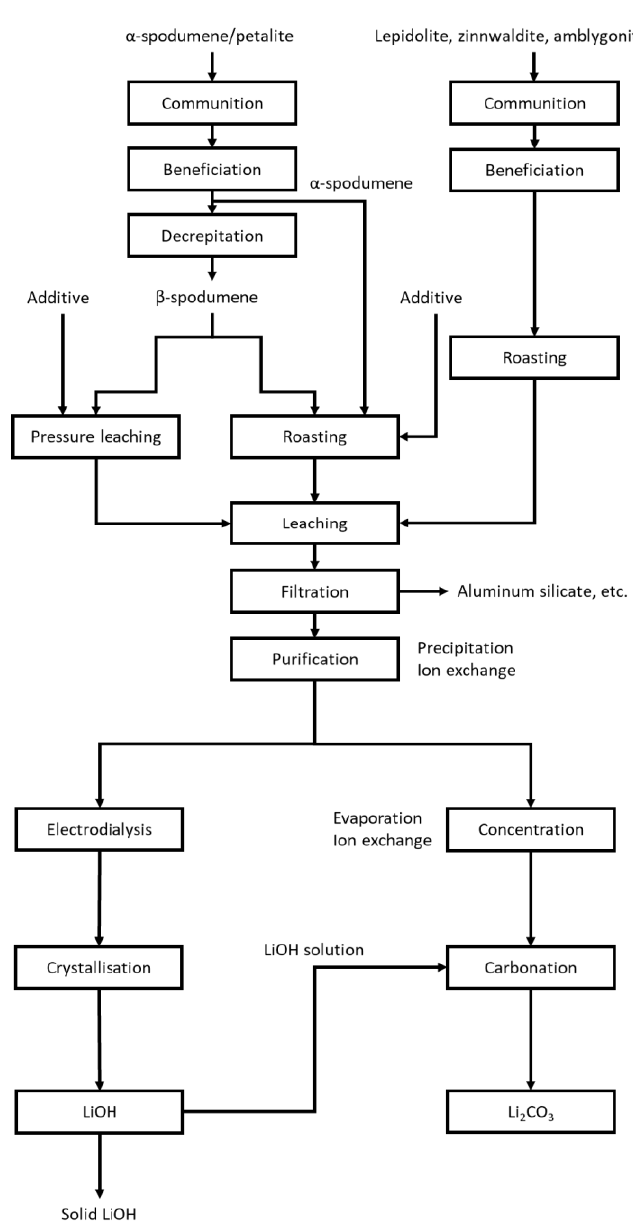
Figure 11. Flow sheets for the production of lithium compounds from mineral sources. Few steps, such as electrodialysis, have only been tested in feasibility studies [45] (adapted with permission from Elsevier Books, Lithium Process Chemistry; published by Elsevier, 2019) .